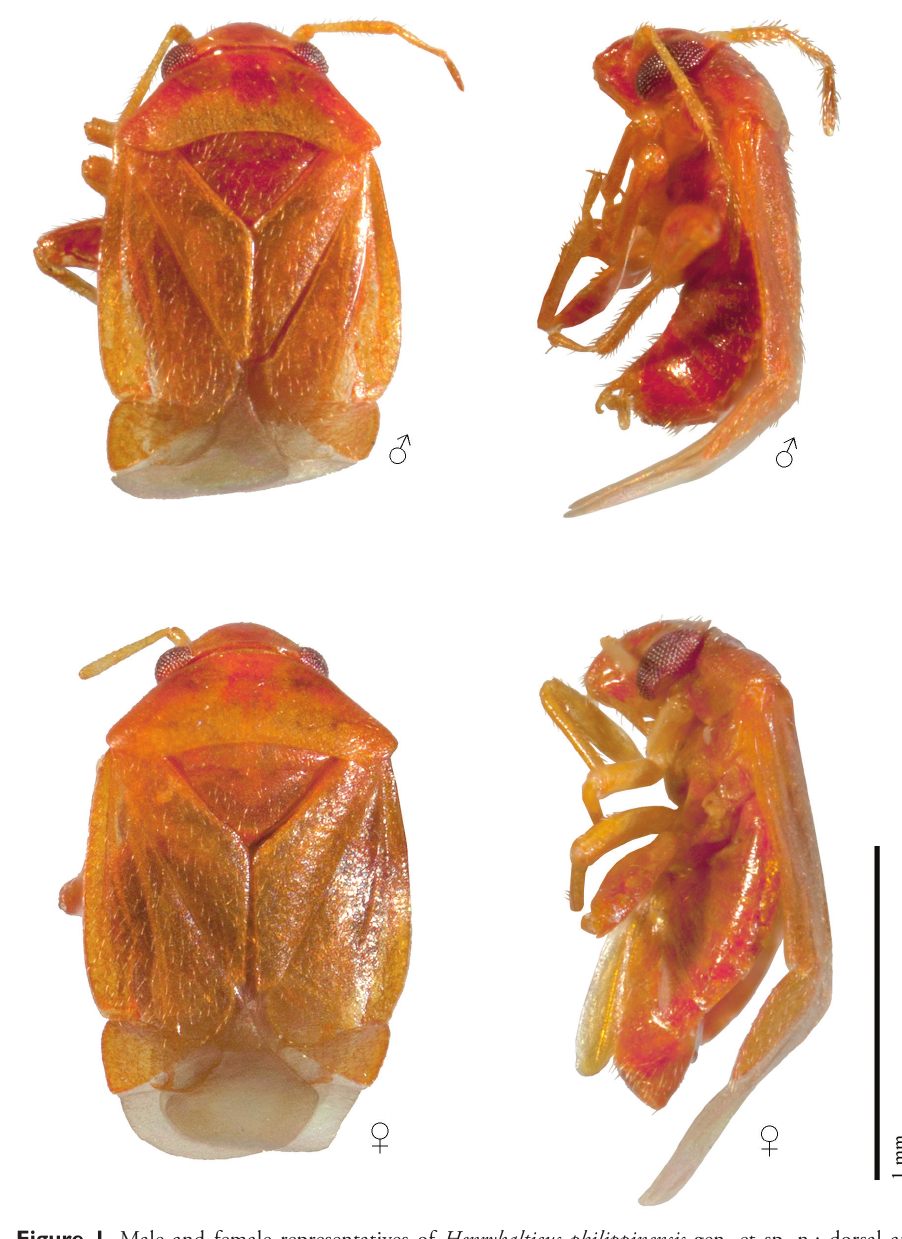
Figure 1. Male and female representatives of Henryhalticus philippinensis gen. et sp. n.; dorsal and lateral